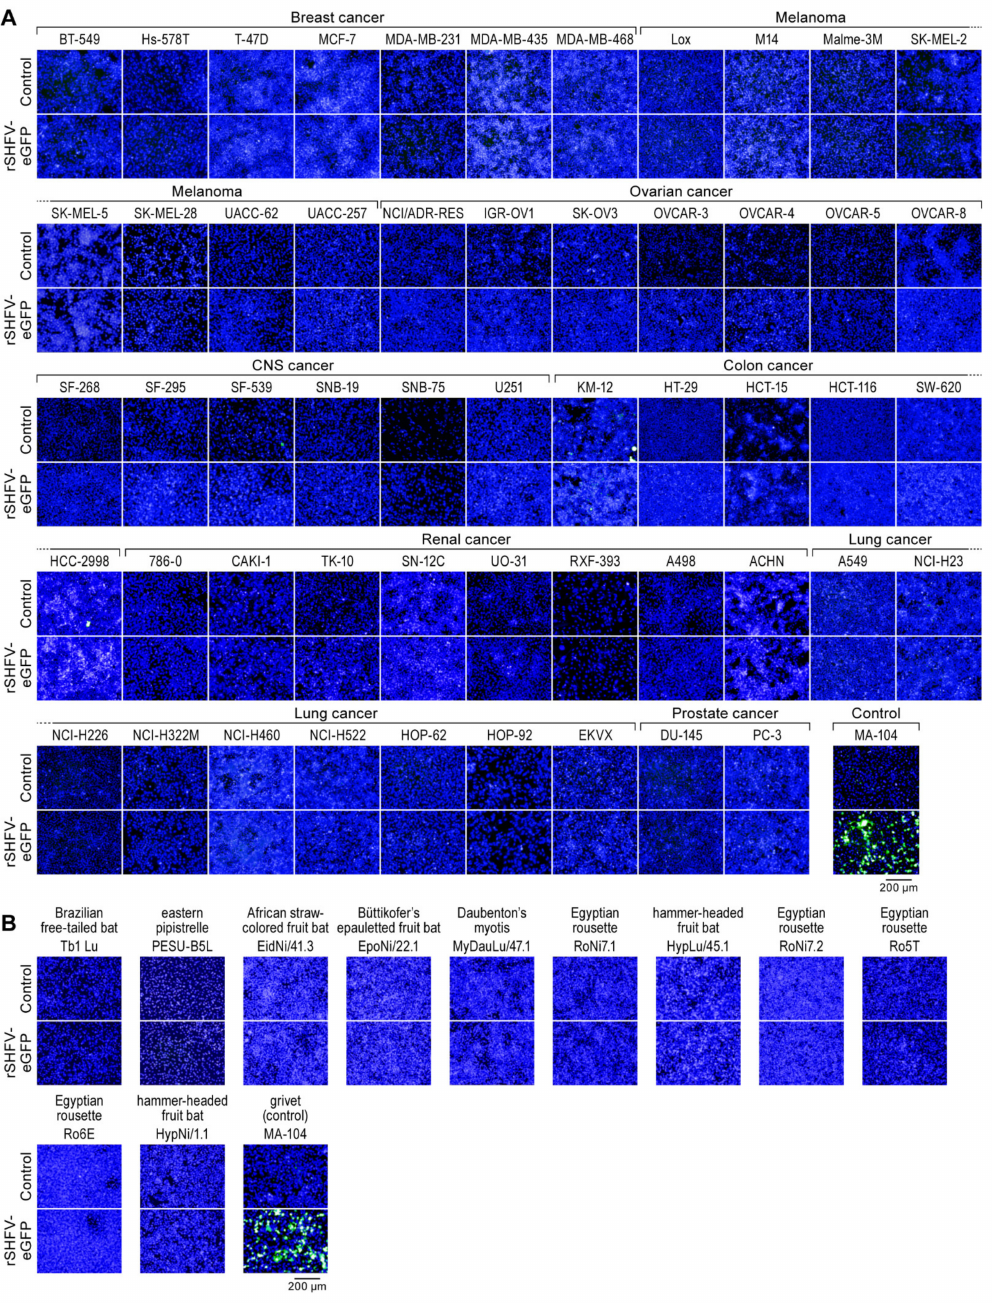
Figure 3. Cellular tropism of simian hemorrhagic fever virus (SHFV): Recombinant wild-type SHFV expressing enhanced green fluorescent protein-expressing (rSHFV-eGFP) does not infect human or bat cells. ( A ) 53 adherent cells of the human NCI-60 cancer cell line panel and ( B ) 11 bat cell lines were exposed to rSHFV-eGFP at a multiplicity of infection of 3. Shown are high-content images of mock-exposed controls and virus-exposed cells counterstained with Hoechst33342 at 72 h or 24 h post-exposure for positive control MA-104